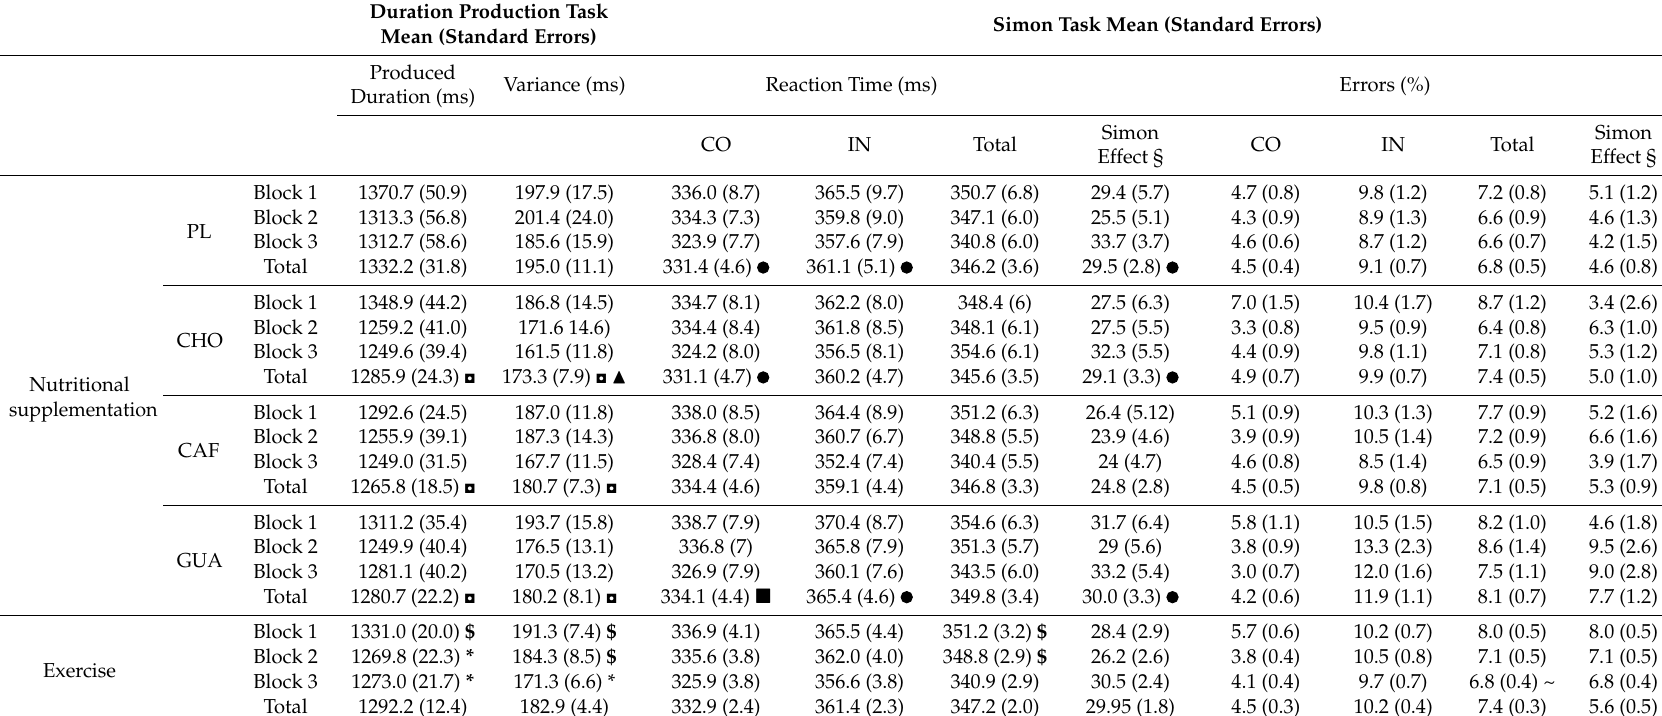
Table 2. Cognitive performance as a function of nutritional supplementation and